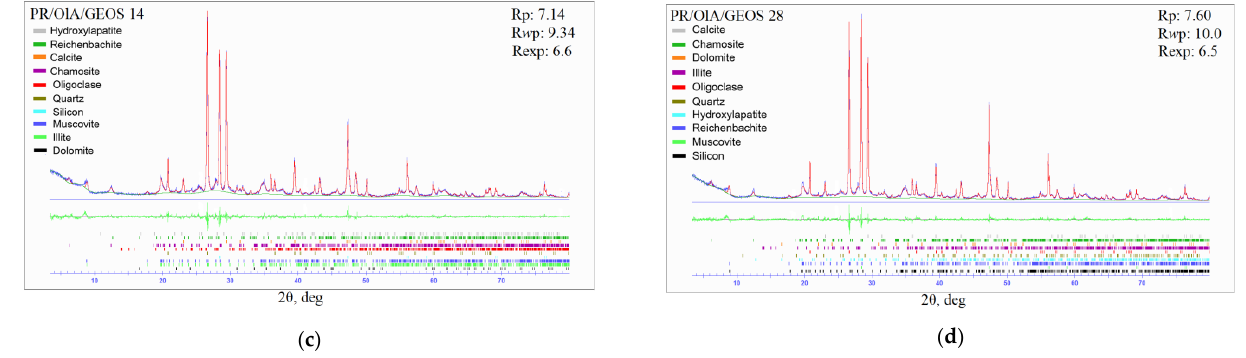
Figure 4. XRPD patterns refined by means of the Rietveld method for PR/OlA/GEOS samples after 1 ( a ), 7 ( b ), 14 ( c ), and 28 ( d ) days of curing with the addition of the external standard (crystalline silicon—Si). See Figure 3 for details.